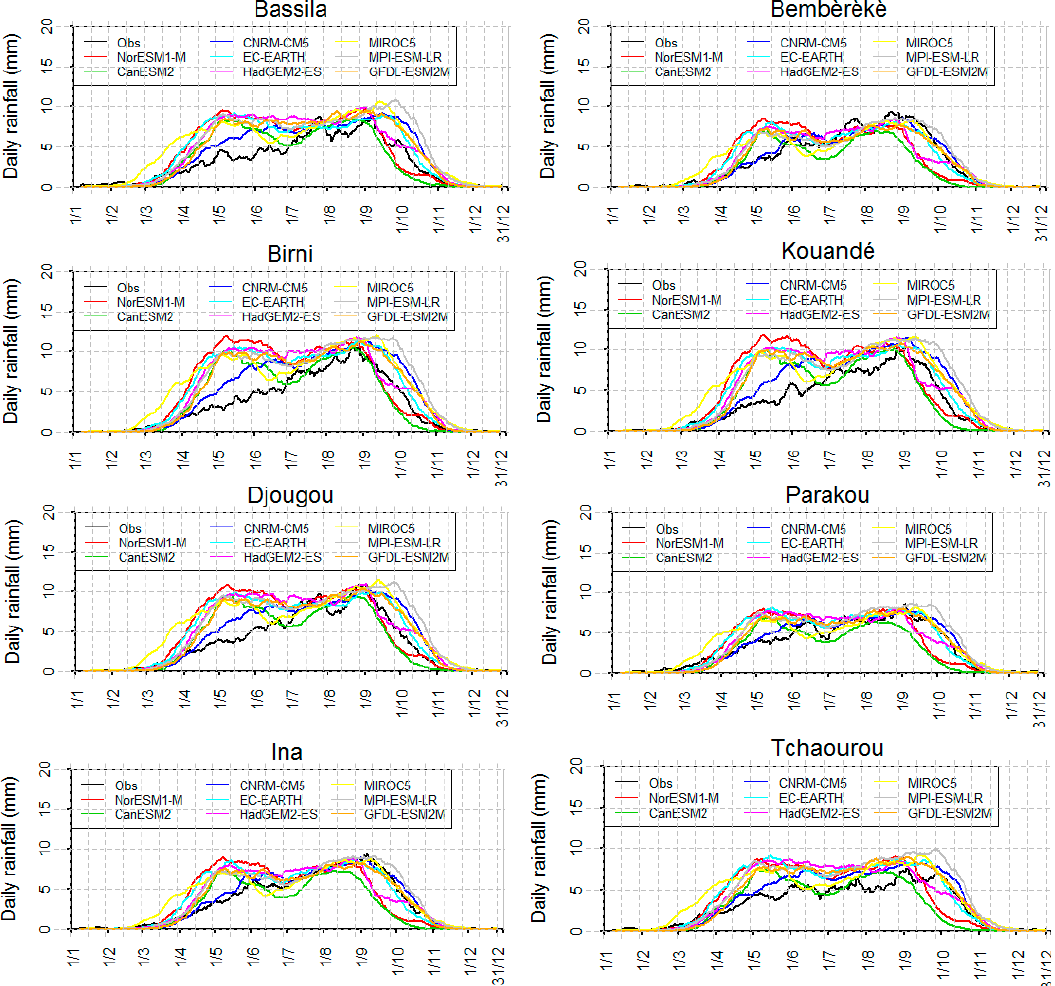
Figure 10. Comparison of observed and simulated data seasonal cycles.